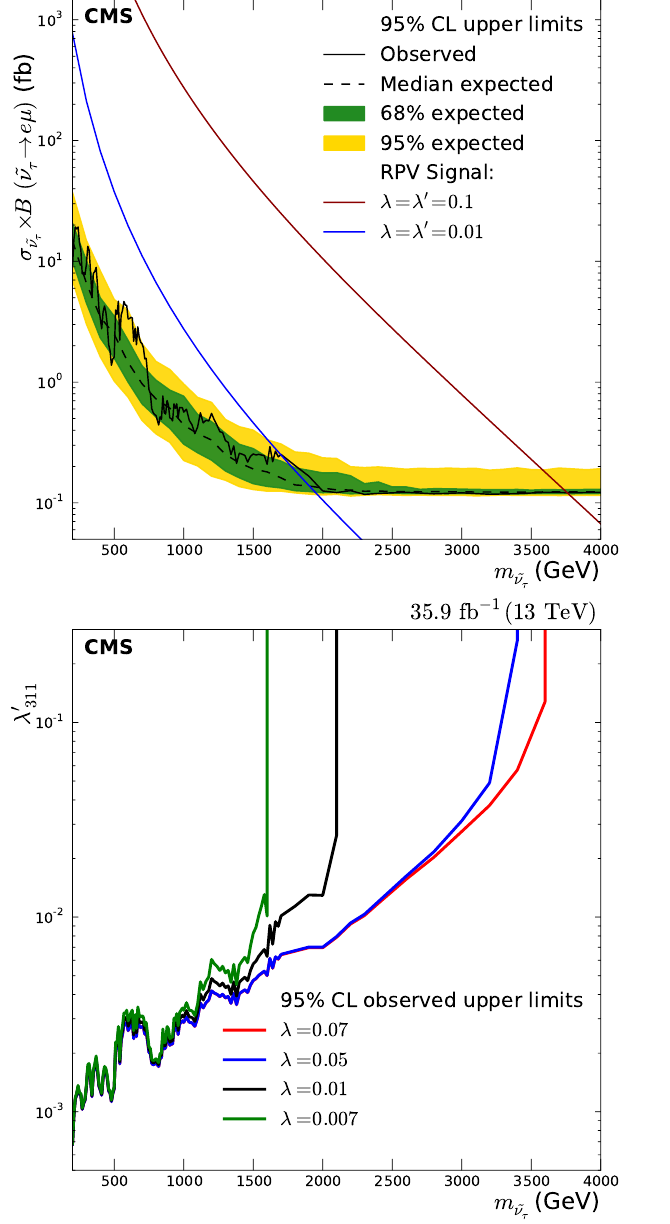
Figure 3 . Upper: upper limits at 95% CL on the product of the signal cross section and branching fraction for the (cid:23) (cid:28) signal, as a function of the mass of the RPV resonance. The 68 and 95% CL e intervals on the median expected limits are indicated, respectively, by the inner green and outer yellow shadings. Predictions for an RPV SUSY model are shown for two values of the coupling parameter. Lower: upper limits at 95% CL on the RPV plane, for four values of (cid:21) , where the regions to the left of and above the limits are excluded. In both (cid:12)gures (cid:21) refers to (cid:21) 132 = (cid:21) 231 , while (cid:21) 0 stands for (cid:21) 0